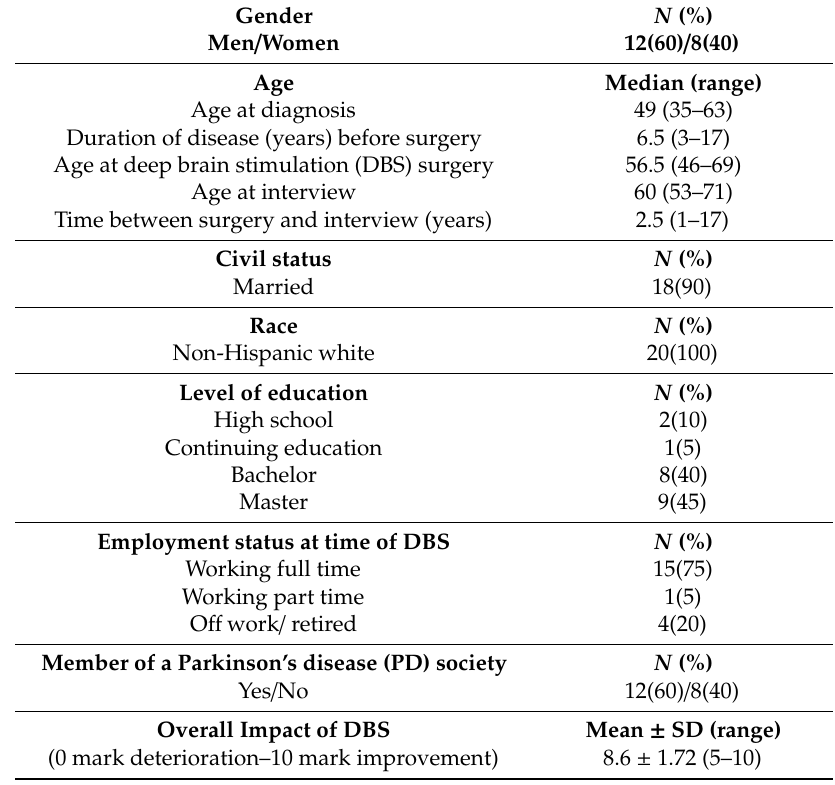
Table 1. Socio-demographic and clinical characteristics in 20 patients with Parkinson’s